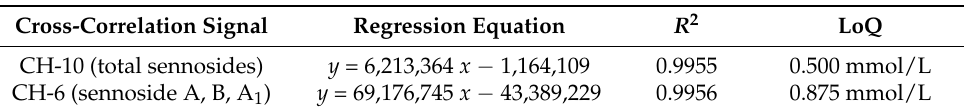
Table 1. Regression equations for the surrogate standard aloin, coefficients of determination ( R 2 ), and limit of quantification (LoQ).